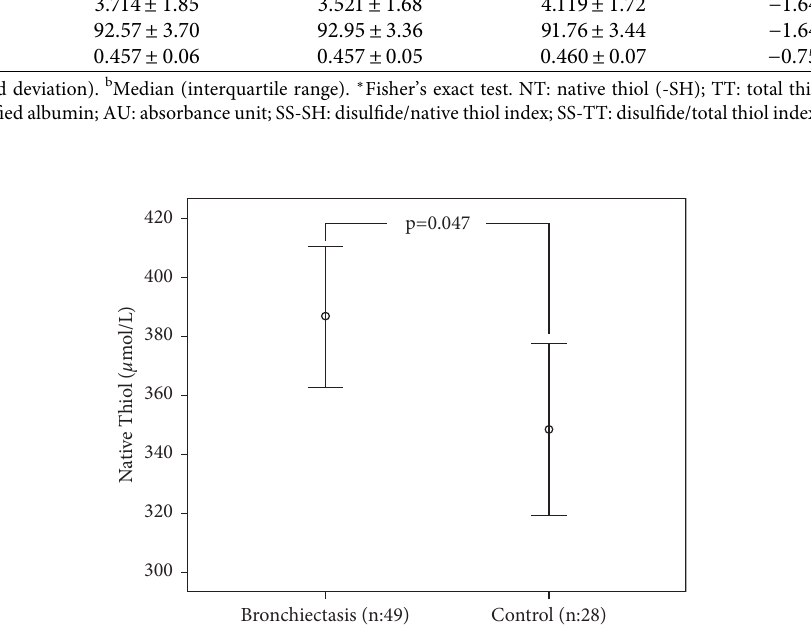
Figure 1: Comparison between the native thiol levels in patients with bronchiectasis and the control group with an error bar graph. Table 2: Disease-related features of patients with stable bronchiectasis ( n �